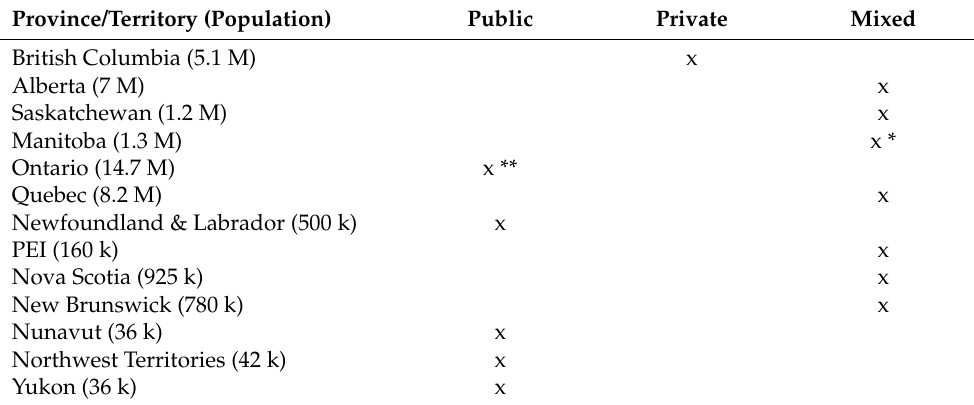
Table 1. Public and Private Sector Enforcement Agencies by Province and